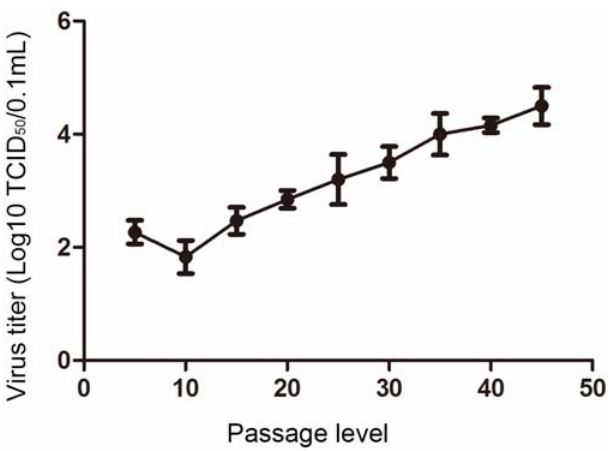
Figure 2. Viral titers of PEDV strain NJ propagated in IECs post-serial passages. All the results of a representative experiment performed with triplicate samples are shown.